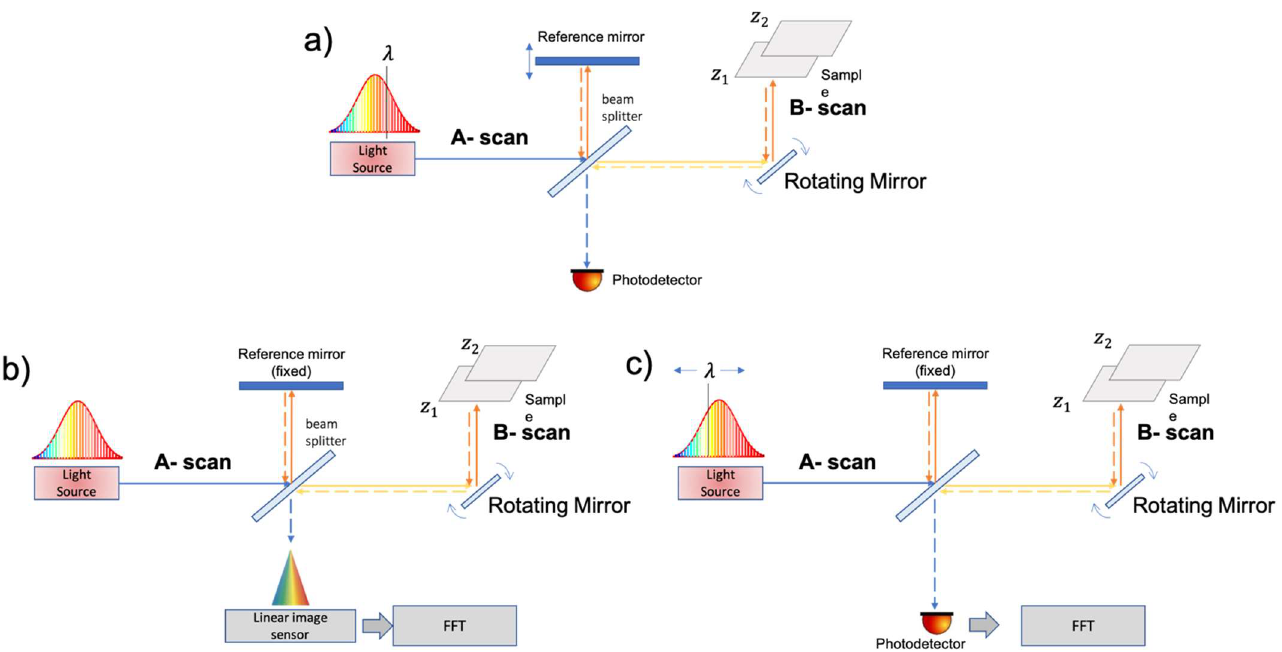
Figure 3. Schematic drawing of Michelson interferometer for time domain optical coherence tomography (TD-OCT) ( a ), spectral-domain OCT (SD-OCT) ( b ), and swept-source OCT (SS-OCT) ( c ). In the TD-OCT and SS-OCT, the detector is a photodiode; in SD-OCT, the detector is a spectrometer.